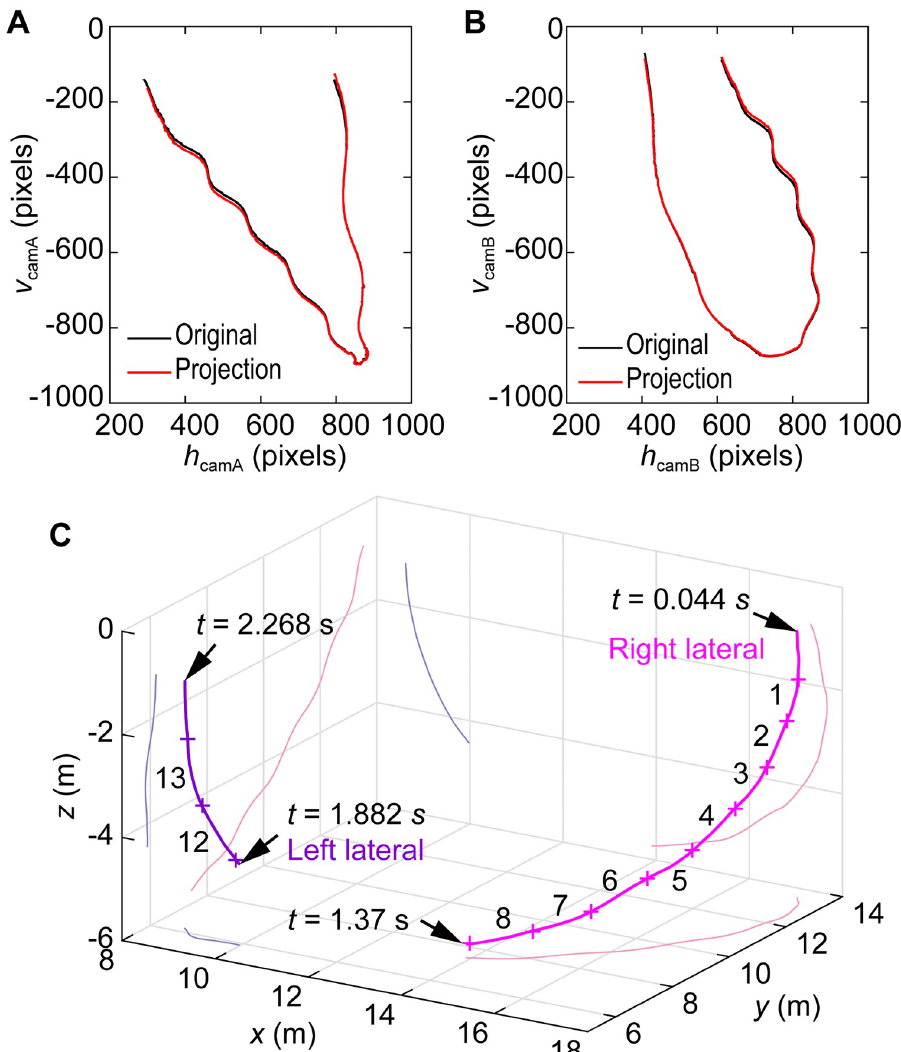
Fig 6. Trajectories of the markers. (A, B) Projection and original trajectories of the beak marker for Camera A and B. (C) 3-D trajectory of the right and left lateral makers of the dolphin with the stroke numbers. t = 0 s was the time when the entire body slipped underwater. The beak reached the water surface at t = 2.232 s. See also S1 and S2 Datasets for the 3-D coordinates before and after lowpass filtering.